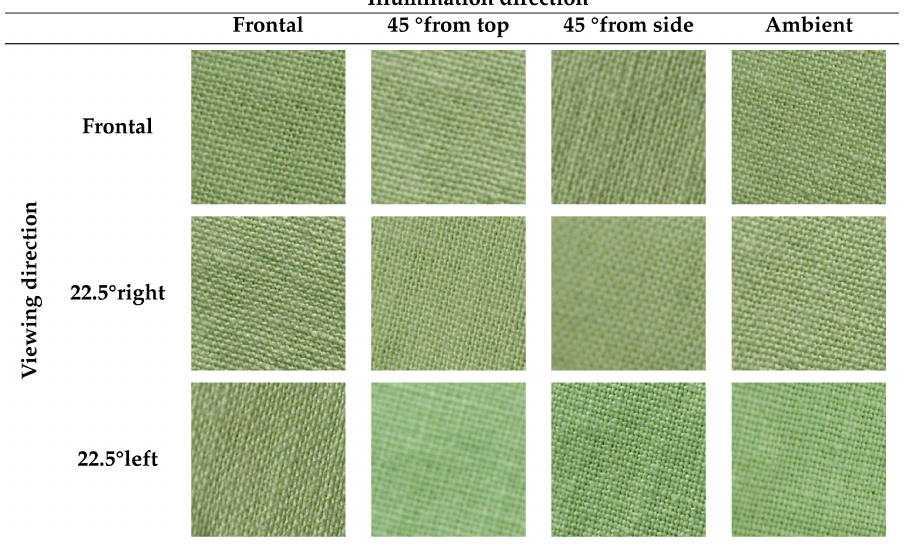
Figure 6. Images of a cotton sample from the KTH-TIPS2 dataset observed under different views. Table 2. Viewing and illumination condition for selected views from the UJM-TIV dataset shown in Figure 5. View Viewing Direction Illumination Direction View1 90° 90°